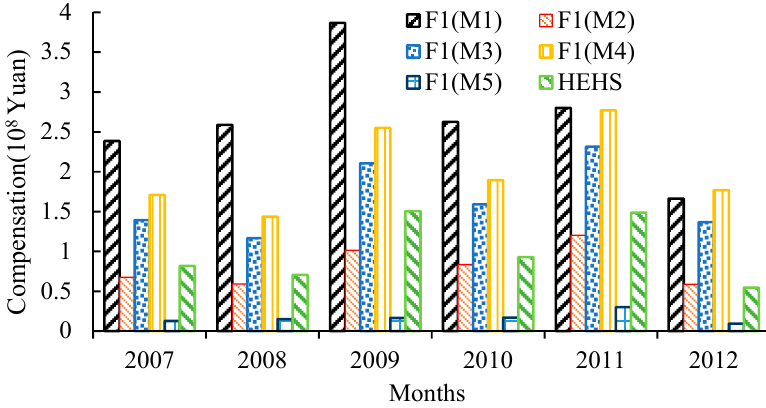
Figure 4. Variations in the calculated compensations for agricultural economic losses caused by the healthy eco-hydrological sequence of rivers.